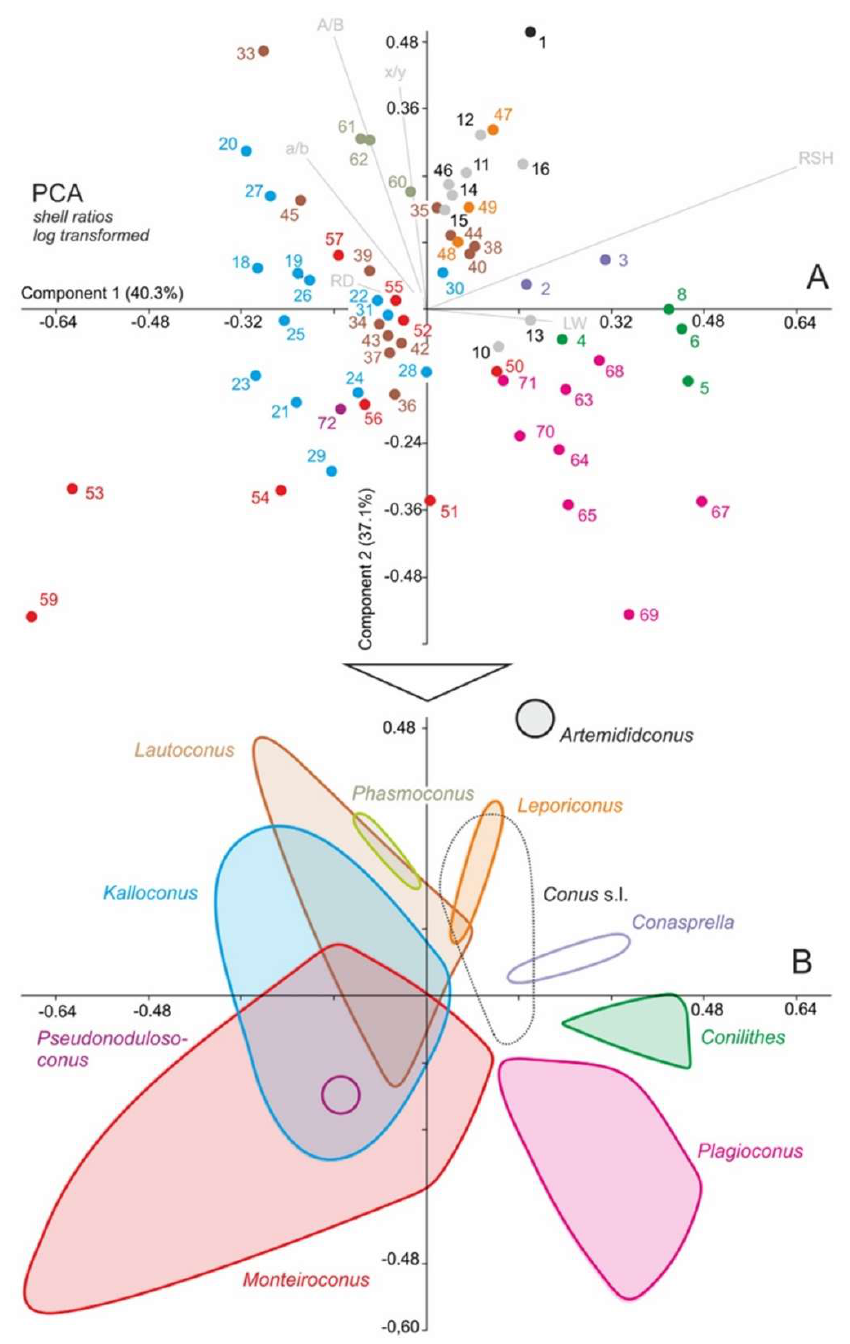
Figure 8. Separation of the species and morphospace occupied by genera as shown by principal component analysis (after [54]).